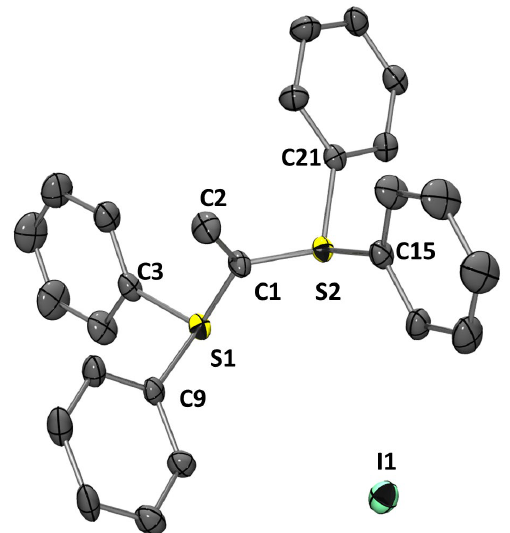
Figure 2. Molecular structure of C-methylated salt 3 . Ellipsoids are drawn at the 30% probability level; hydrogen and disordered atoms are omitted for clarity. Selected bond lengths (Å) and angles ( ◦